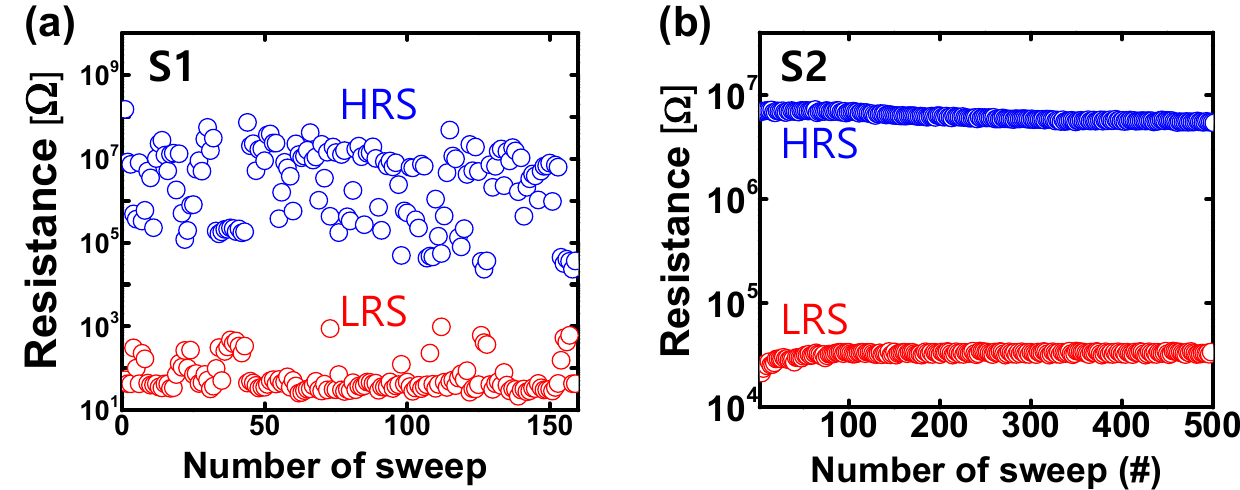
Figure 2. Endurance switching characteristics of ( a ) S1 and ( b ) S2 read at 0.1 V.